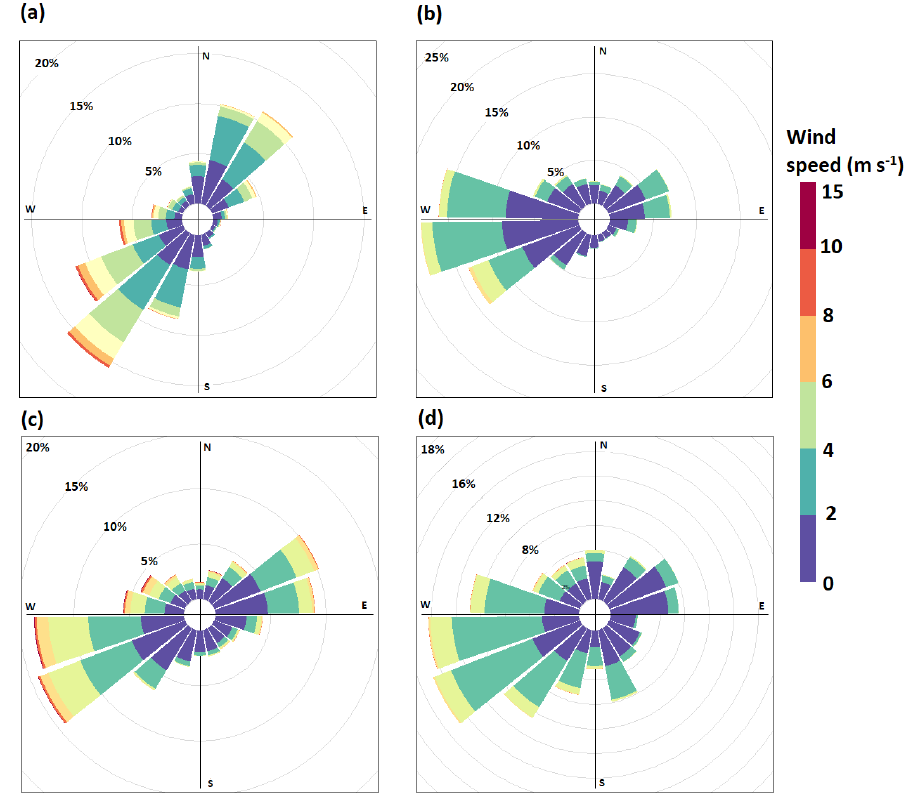
Figure A3. Wind rose for three stations located in the Balice valley (a) , Reymonta St. (b) , Igołomia (c) and one at the nearest hilltop stations Libertów (d) for cold seasons